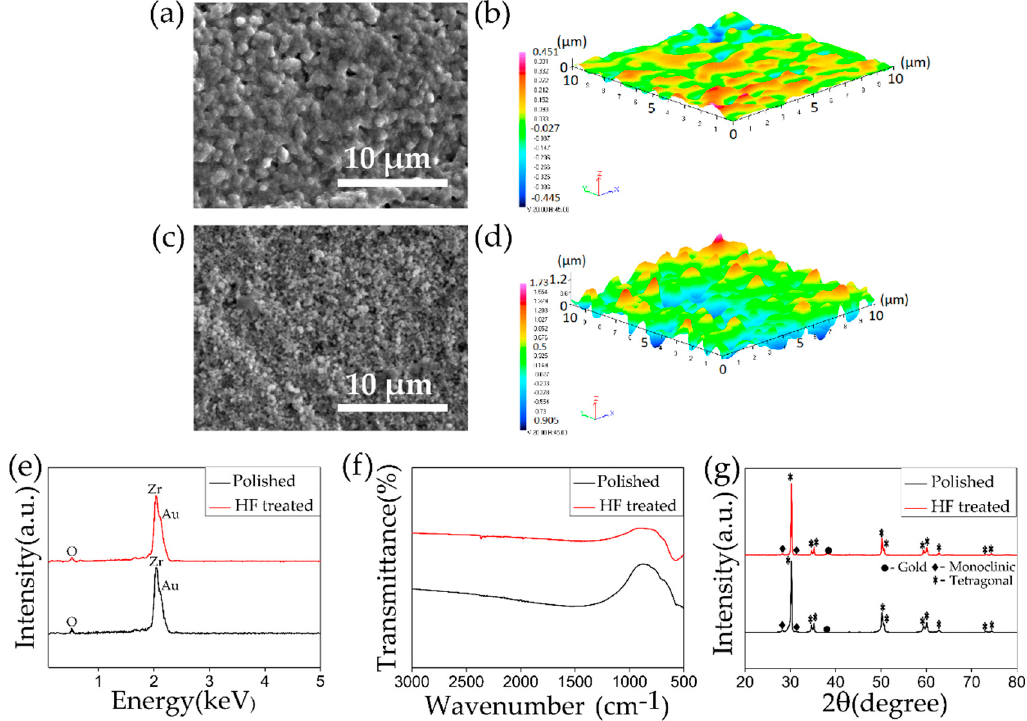
Figure 1. ( a , c ) SEM images and ( b , d ) 3D images of ( a , b ) polished and ( c , d ) hydrofluoric acid (HF)-treated tetragonal zirconia polycrystal (3Y-TZP) surface. ( e ) EDX, ( f ) FTIR, and ( g ) XRD plots comparing 3Y-TZP samples before (polished) and after HF etching.